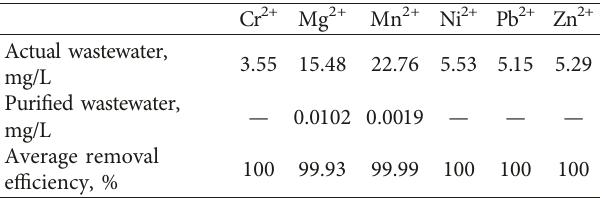
Table 2: Results of heavy metal ions